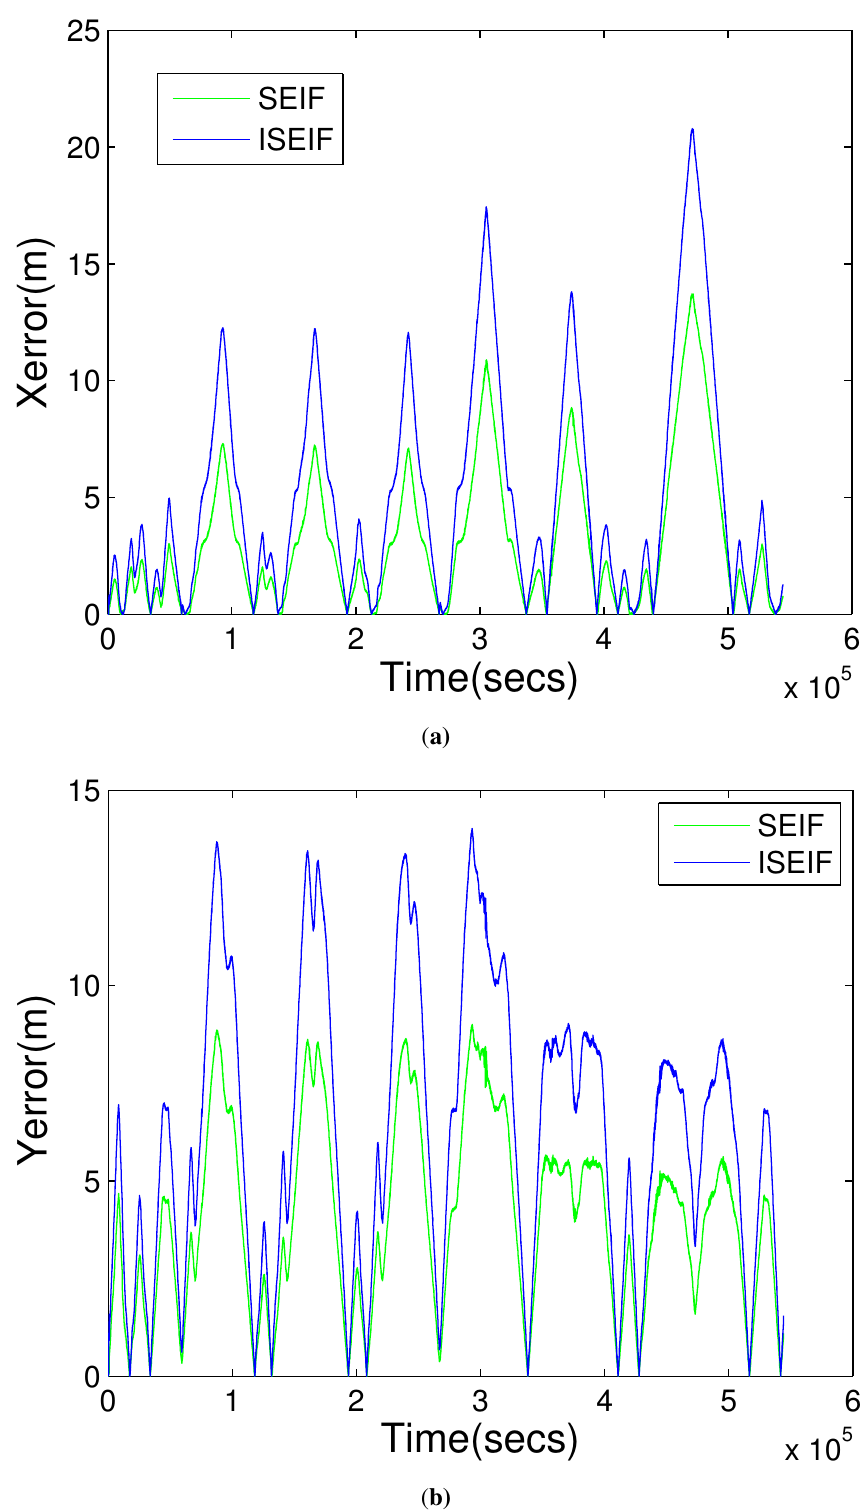
Figure 8. The RMS error comparison between SEIF and ISEIF relative to GPS, where ( a ) is the error in horizontal coordinate and ( b ) is in vertical